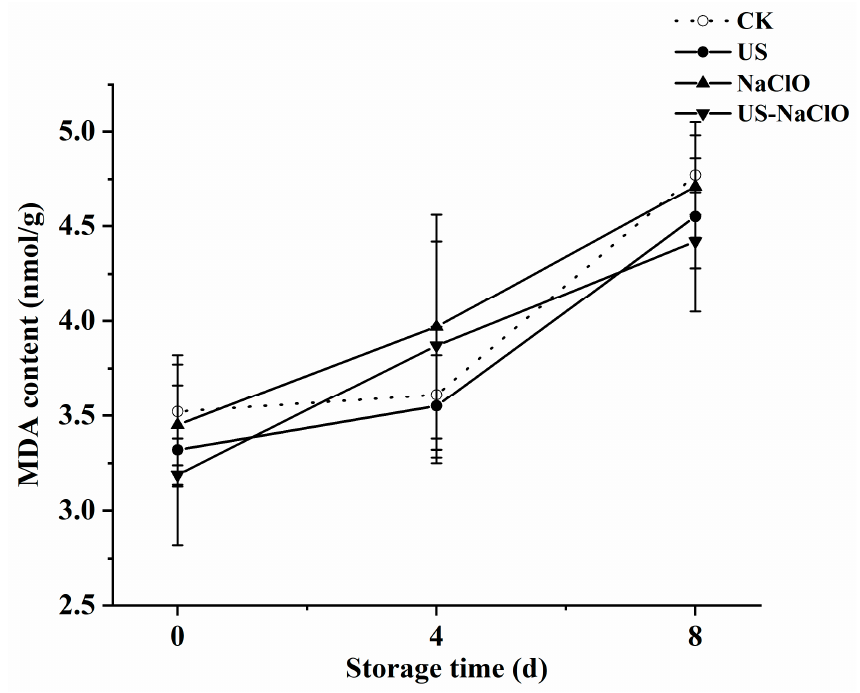
Figure 2. Effects of US, NaClO and US-NaClO treatment on MDA content of fresh-cut cucumber during storage.